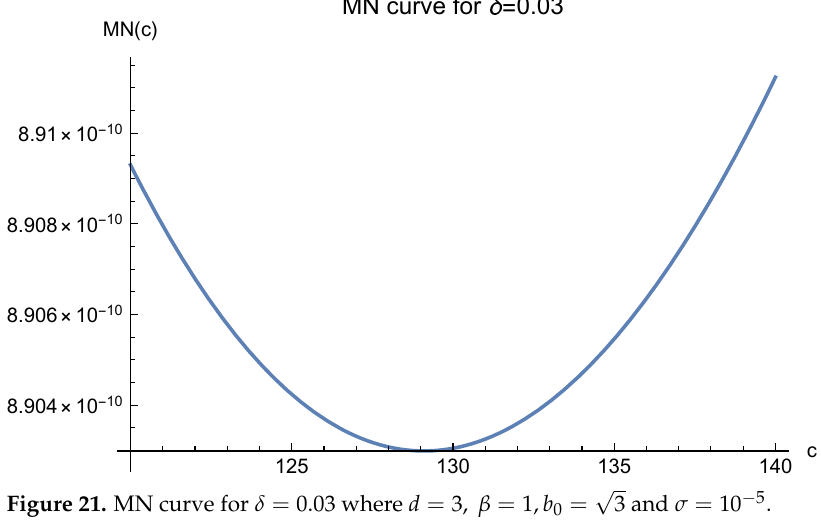
Figure 21. MN curve for δ = 0.03 where d = 3, β = 1, b 0 =